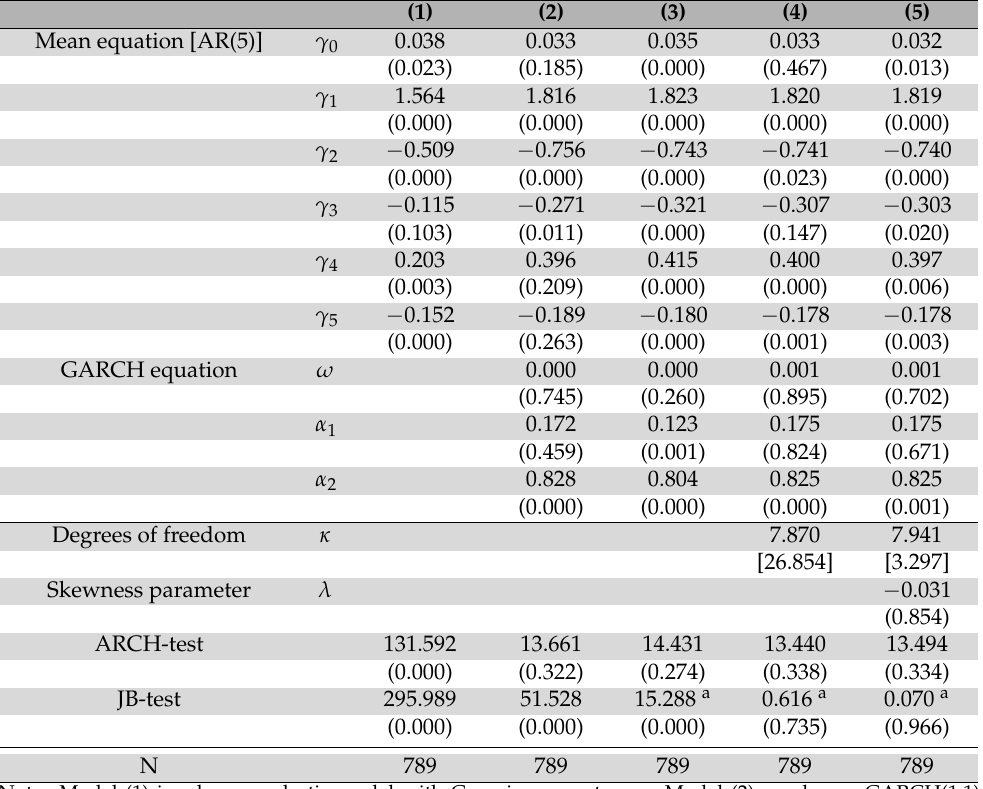
Table 3. Within–sample estimation